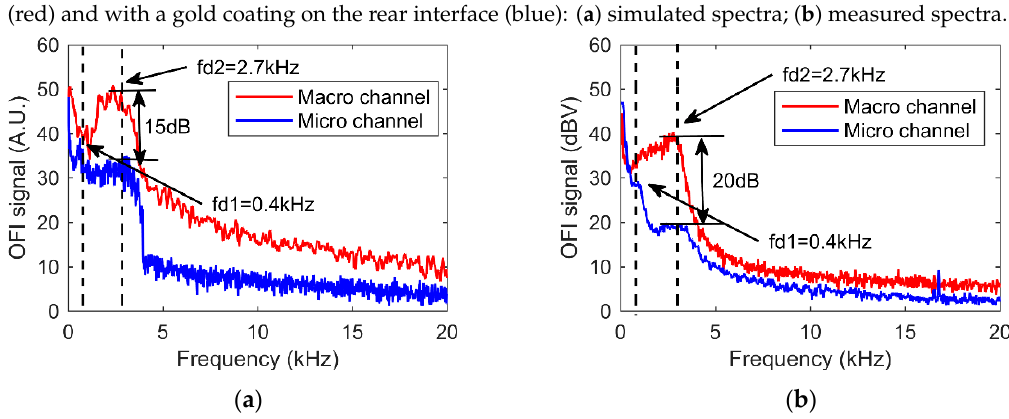
Figure 8. The OFI signal frequency spectra obtained with PS particles of PDMS macro channel at Q = 100 µL/min (red), DF micro channel Q = 1 µL/min (blue): ( a ) simulated spectra; ( b ) measured spectra. Q = 100 µ L / min(red), DFmicrochannelQ = 1 µ L / min(blue): ( a )simulatedspectra; ( b